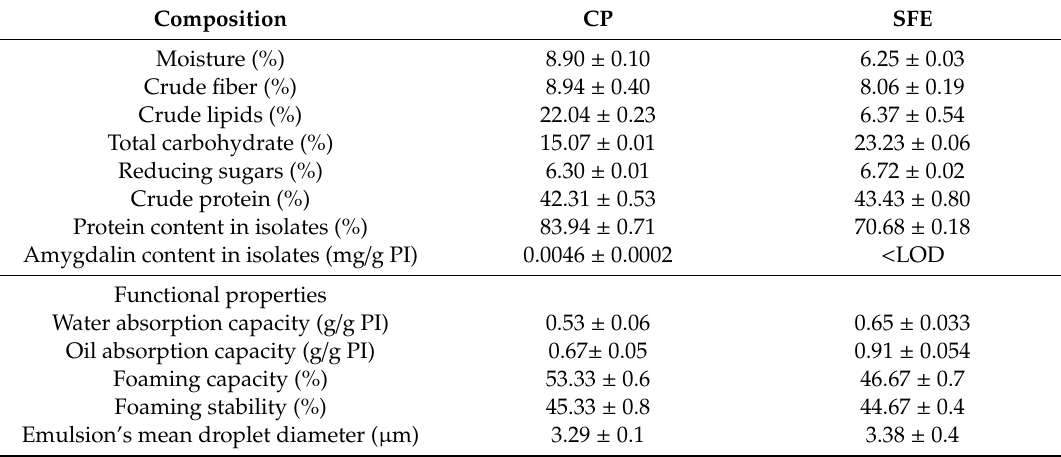
Table 1. Chemical compositions of apricot oil cakes and protein isolates and functional properties of protein isolates obtained from oil extraction by cold pressing (CP) process and supercritical fluid extraction